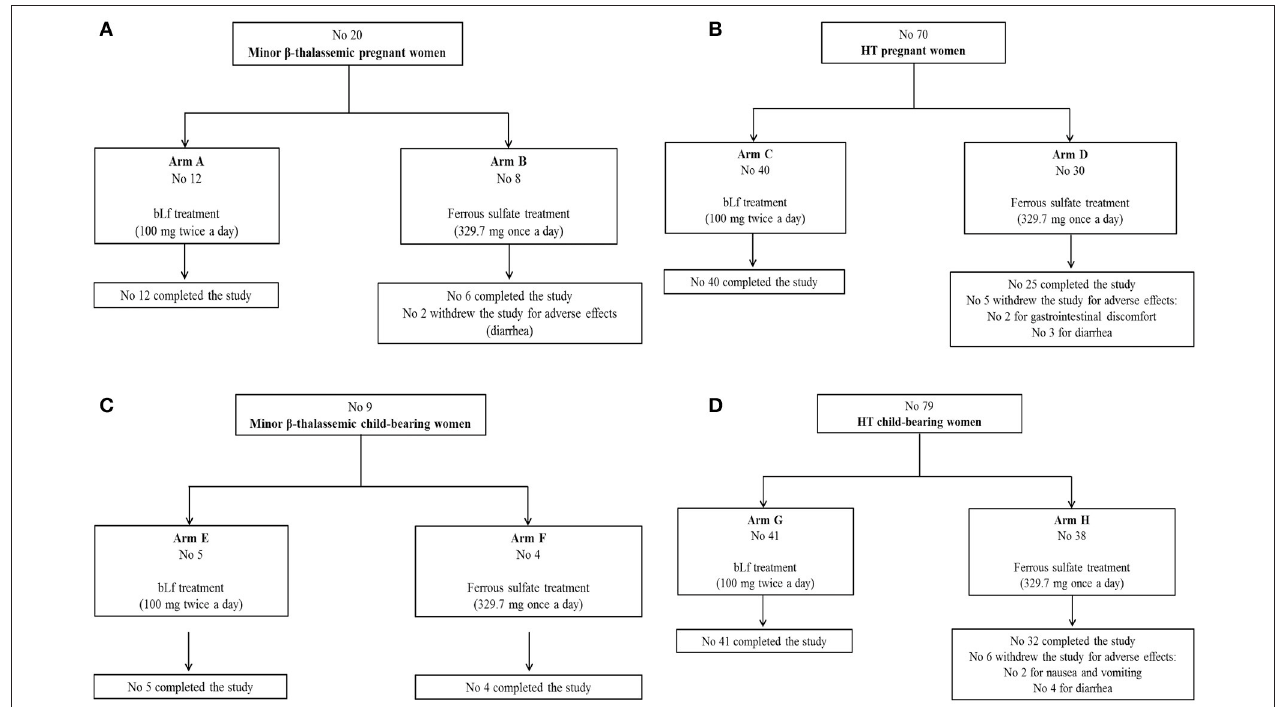
FIGURE 1 | Flow diagrams of enrolled pregnant women suffering from minor β -thalassemia (A) , pregnant women suffering from hereditary thrombophilia (B) , women of child-bearing age suffering from minor β -thalassemia (C) , women of child-bearing age suffering from hereditary thrombophilia (D)